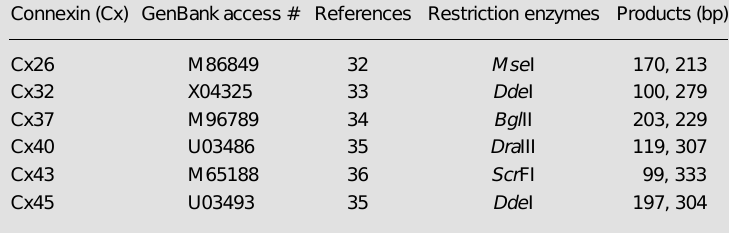
Table 2 - Predicted unique cleavage sites for human gap junction proteins deduced from cDNA sequences. References for GenBank database accession numbers, molecular cloning, restriction enzymes and predicted cleavage